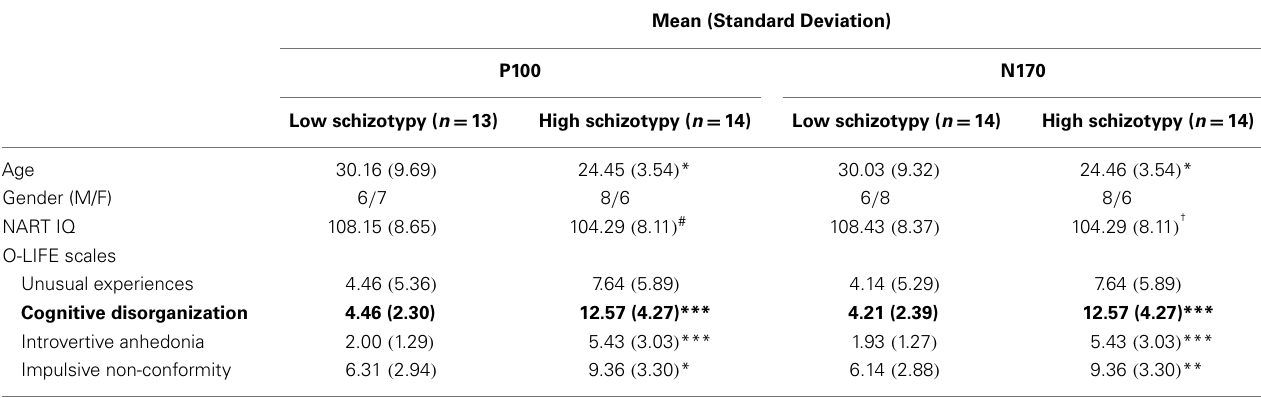
Table 1 | Demographic characteristics of high and low schizotypy